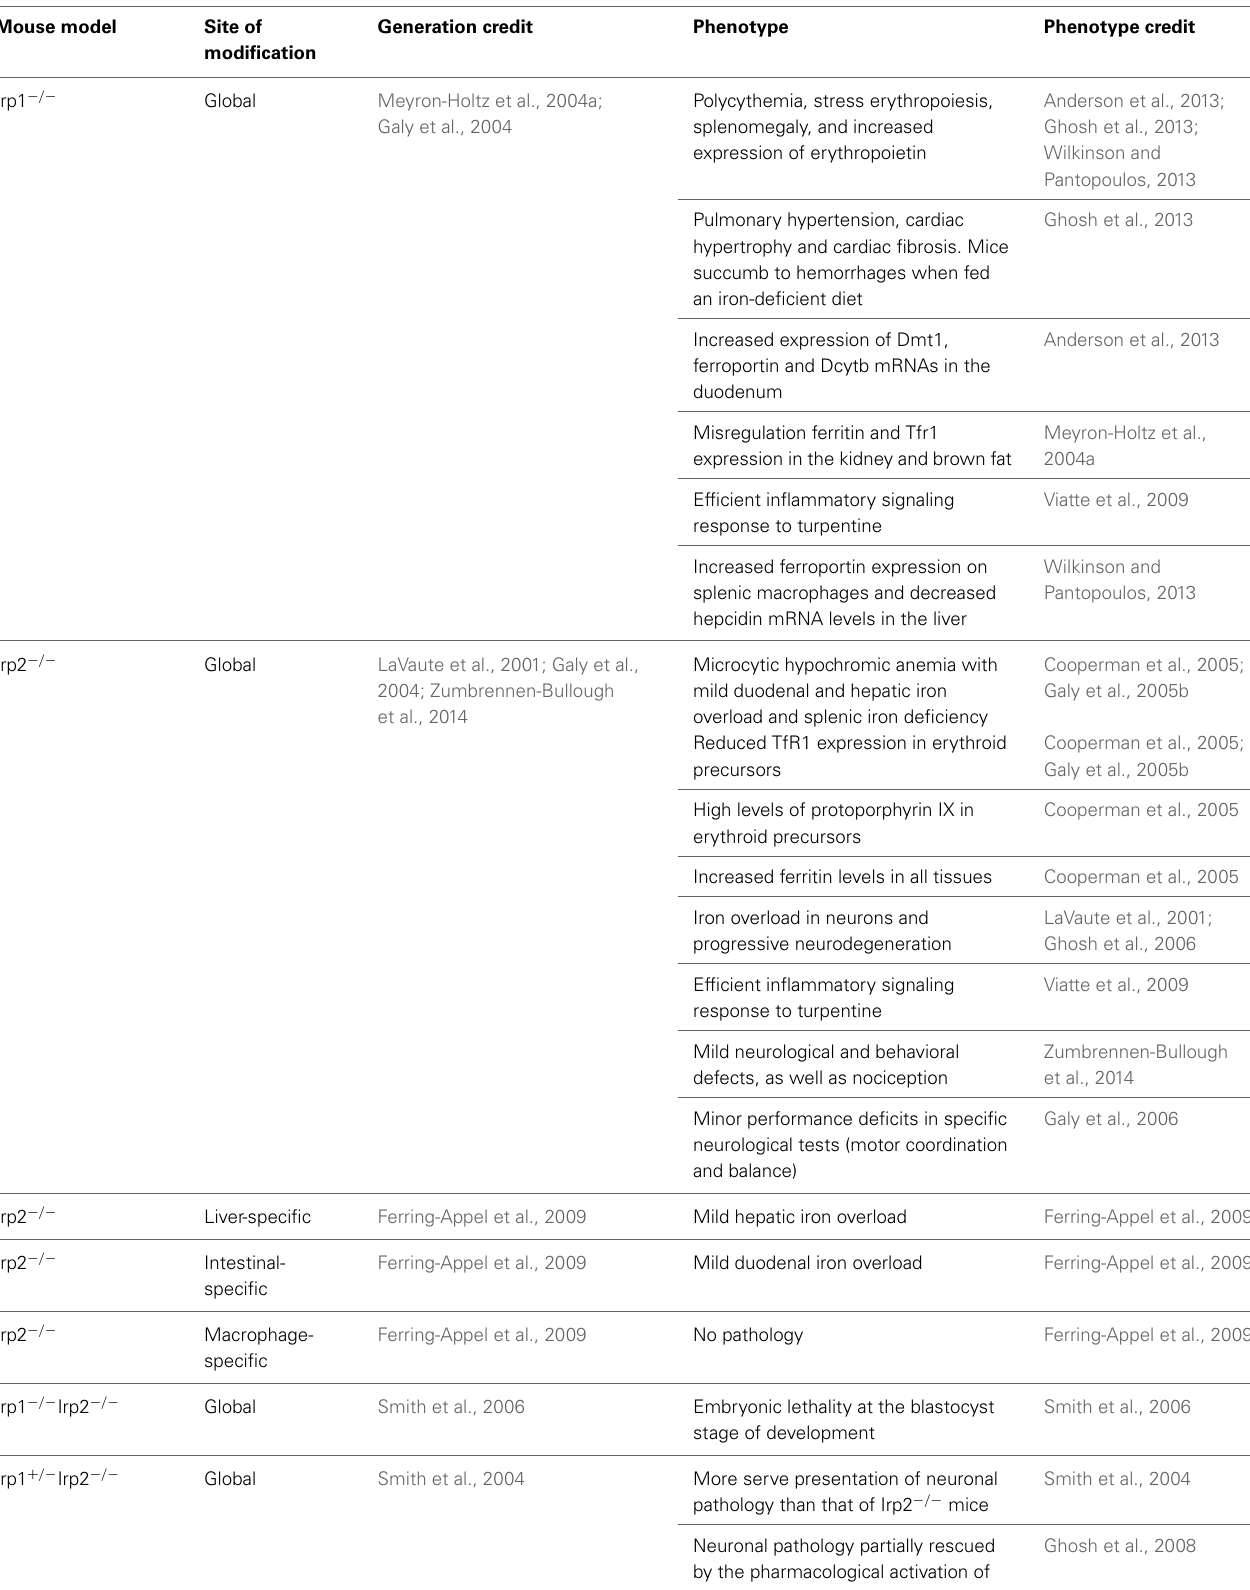
Table 3 | Phenotypic features of mouse models with global or tissue-specific “loss” or “gain” of Irp1 and/or Irp2